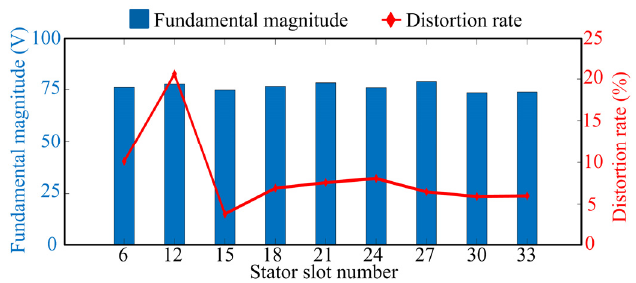
Figure 2. The variation in back electromotive force (EMF) with the variation in the number of stator slots when the number of rotor poles is 4.